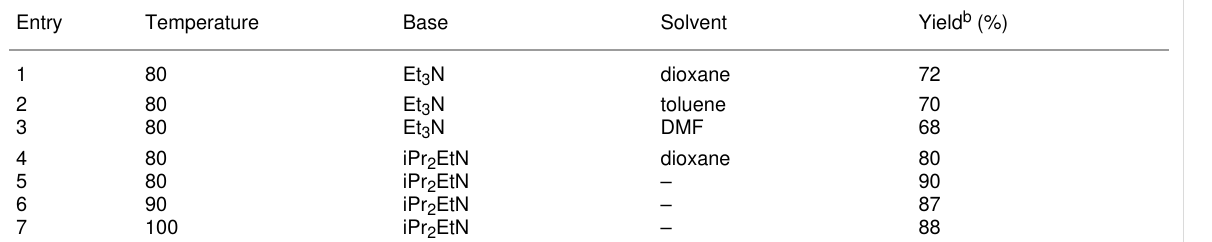
Table 1: Effects of solvent, base, and temperature on the Sonogashira coupling between 2 and 3a .